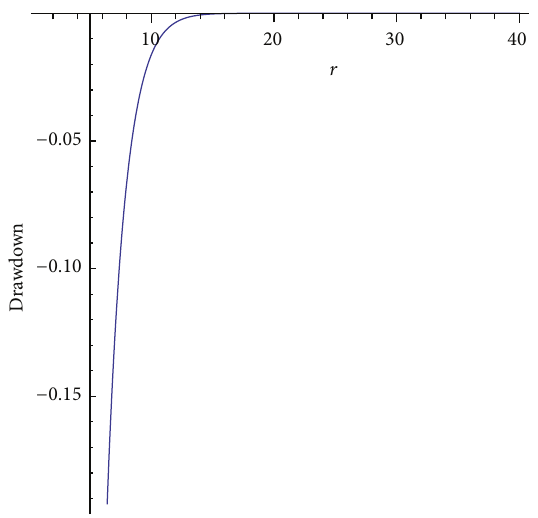
Figure 11: Solution of (41) as function of space (piezometric head).